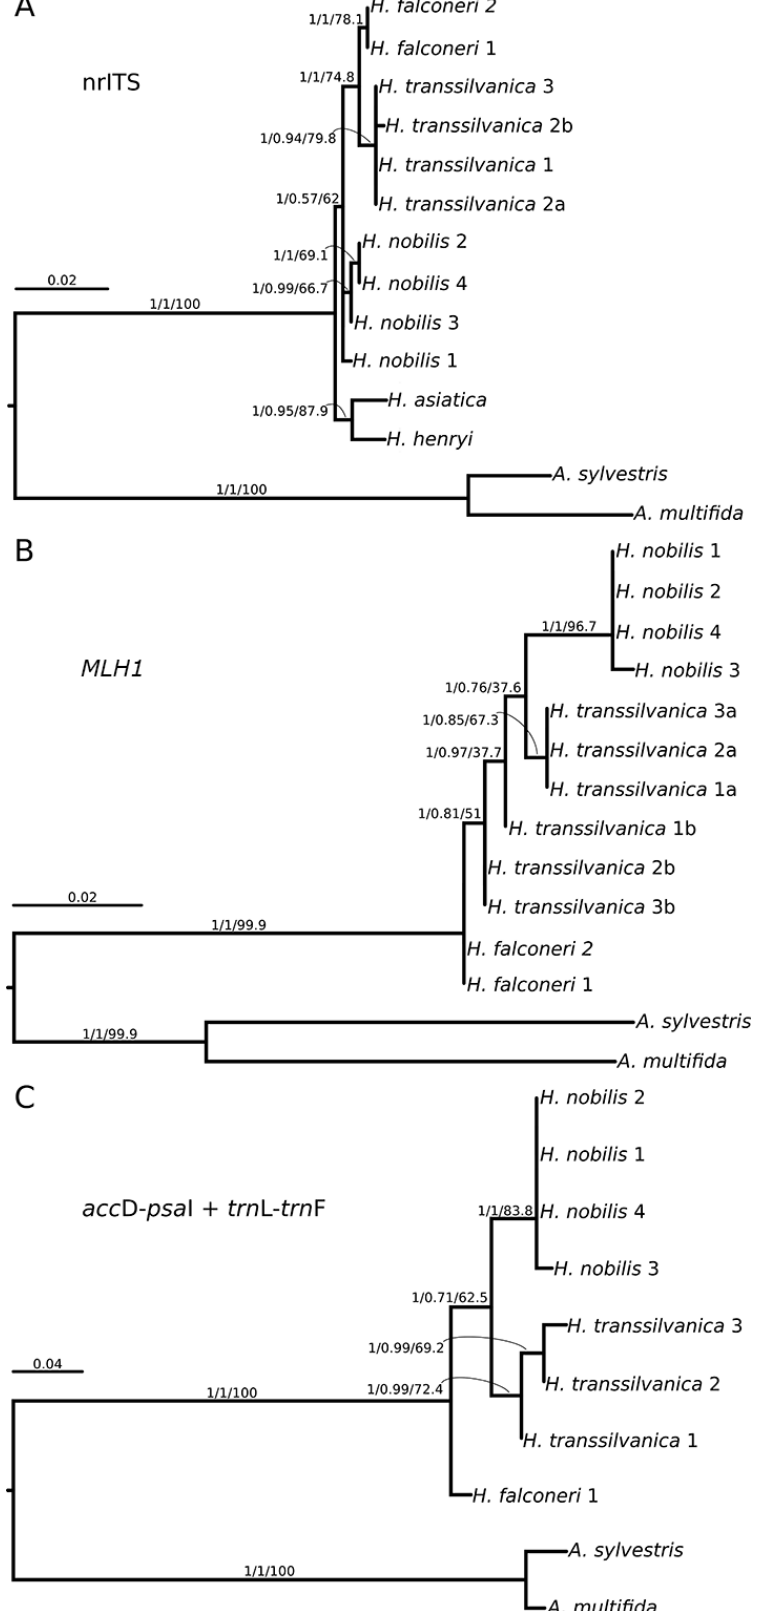
Figure 1 Phylogenetic relationships reconstructed by PhyML using the smart model selection (SMS) for ( A ) nrITS, ( B ) MLH1 , and ( C ) concatenated plastid sequences. Statistical support values above branches correspond to Shimodaira–Hasegawa approximate likelihood ratio test (SH-aLRT)/aBayes/bootstrap (bs)